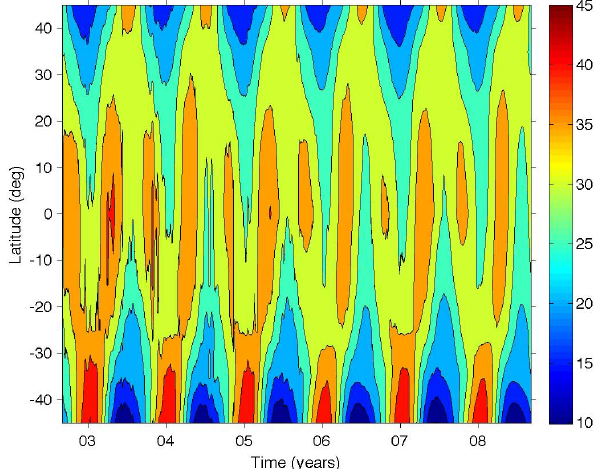
Fig. 28. The daily vertical partial NO 3 column in 25–50km as a function of time and latitude The column is calculated from the time series and scaled by 10 12 moleculescm − 2 .